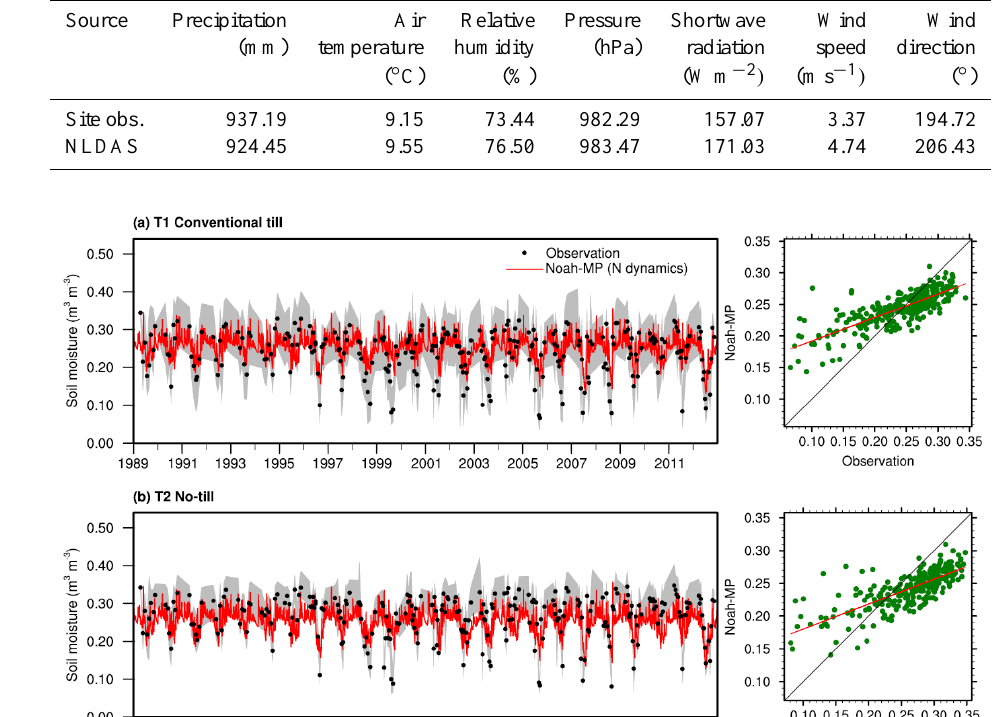
Table 2. Comparison of annual averaged atmospheric forcing data (2008–2014) between site observation and NLDAS. Source Precipitation Relative